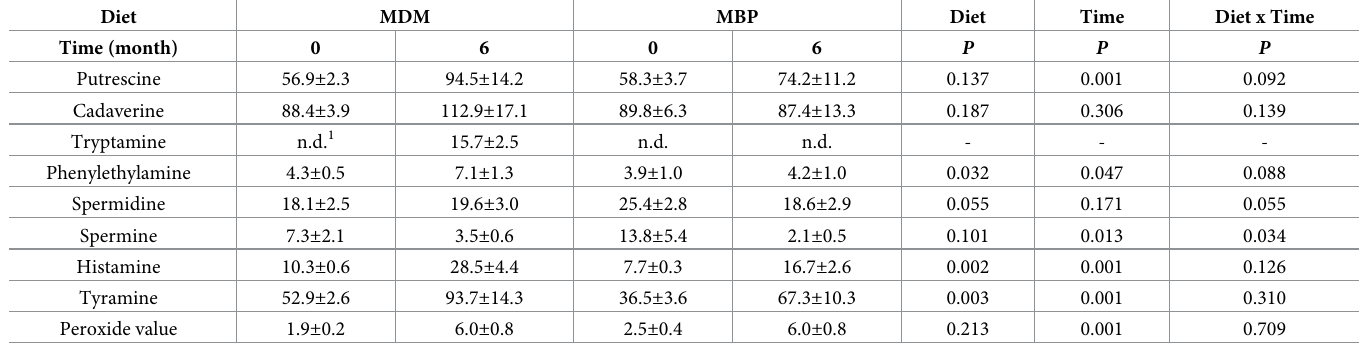
Table 9. Polyamine (mean ± SD mg/kg, as-fed basis) and peroxide content (meq/kg, as-fed basis) of the two diets (MDM = Mechanically Deboned Chicken Meat diet and MBP = Meat By-Products diet) at the start and the end of the conservation period. Diet MDM MBP Diet Diet x Time Time